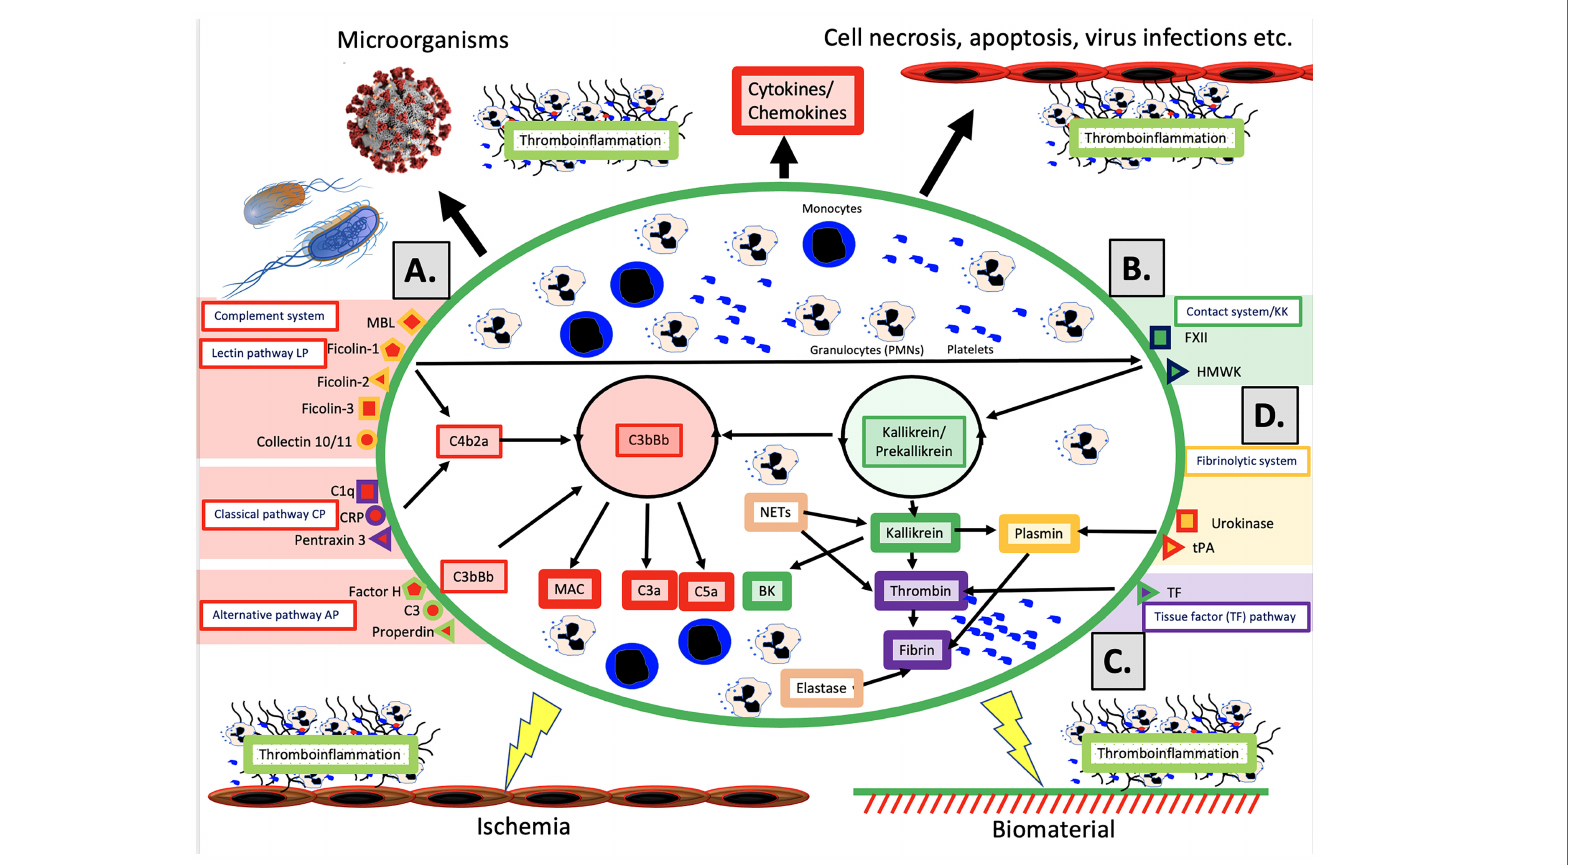
FIGURE 1 | Physiological and pathological conditions and treatments involving IIIS activation. The IIIS consists of the cascade systems of the blood: the complement system (A) , the contact or kallikrein/kinin system (KKS) (B) , the tissue factor (TF) pathway of the coagulation system (C) , and the fi brinolytic system (D) . Activation of IIIS occur in response to physiological stimuli such as microorganisms or necrotic, apoptotic or virus infected cells (top in fi gure), which leads to thromboin fl ammation. But also during pathological or therapeutic conditions such as ischemia during transplantation, or treatment with biomaterials e.g. stents, intravascular devices, and extracorporeal treatment (bottom in fi gure) a similar reaction occur. (A) The complement system has three activation pathways, which are triggered by different recognition molecules. The classical pathway (CP) is initiated by C1q, which binds to antigen bound IgG and IgM, but also to negatively charged surfaces and target-bound pentraxins e.g. CRP and pentraxin 3. The lectin pathway (LP) is activated by a number of carbohydrate binding proteins (lectins) such as mannan binding lectin (MBL), Ficolin-1, -2, -3 and Collectin 10/11 (4). The alternative pathway (AP) is be activated/regulated by surface-speci fi c binding of factor H, C3 or properdin to a target, and has its main role as an ampli fi er. Complement activation leads to assembly of two enzyme complexes C4bC2a and C3bBb, which cleave C3 into the anaphylatoxin C3a and surface bound C3b (opsonization) and cleaves C5, which initiates the formation of the membrane attack complex (MAC) and the more potent anaphylatoxin C5a. (B) The primary function of the kallikrein/kinin and coagulation systems is in hemostasis but both systems are also engaged in in fl ammation. The recognition molecule in the contact/KK system is factor XII (FXII), which is activated, e.g., by negatively charged molecules such as LPS, glycosaminoglycans or extracellular matrix molecules exposed to the blood stream. The KK system also initiates an ampli fi cation loop, which involves prekallikrein that cleaves high molecular-weight kininogen (HMWK) leading to the generation of the proin fl ammatory mediator bradykinin (BK). (C) The main physiological trigger of coagulation, tissue factor (TF), is exposed in a functionally active form only after damage to vessels and activation of blood cells including platelets. It thereby initiates the extrinsic part of the coagulation cascade, which leads to formation of high amounts of thrombin. (D) The fi brinolytic system is initiated when urokinase or tissue plasminogen activator (tPA) activate plasminogen to plasmin, which degrades a formed fi brin network to soluble fi brin fragments. Please see the text for information on the roles of monocytes, PMNs and